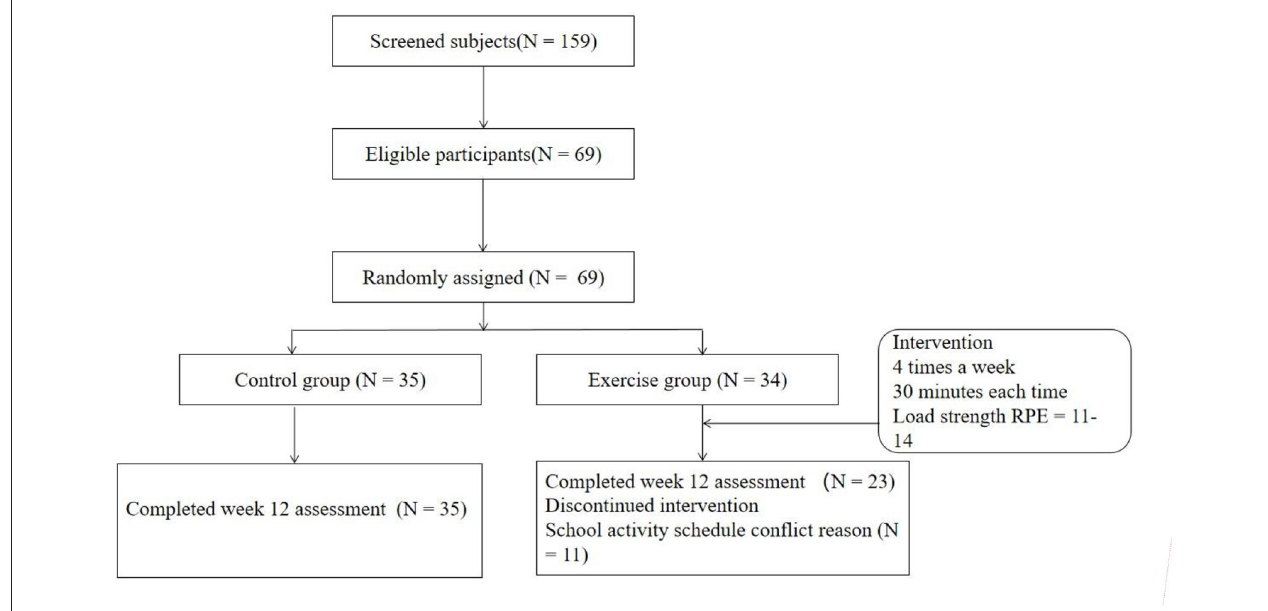
FIGURE 1 | Schematic diagram of aerobic training intervention for 12 weeks.